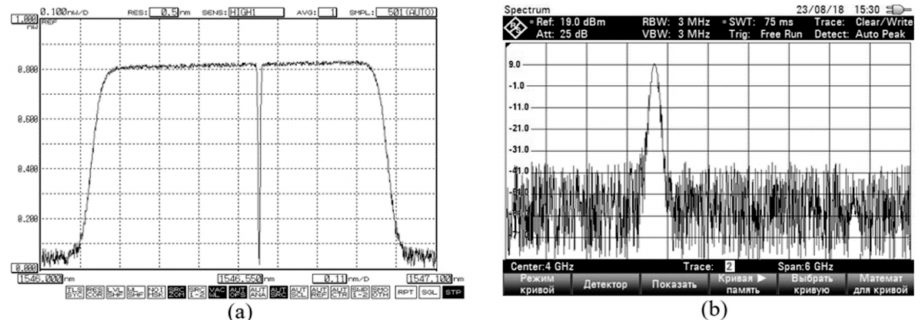
Figure 13. Characteristics of the PS-FBG ( a ) in optical range and ( b ) in radiofrequency range [33,34] © 2019